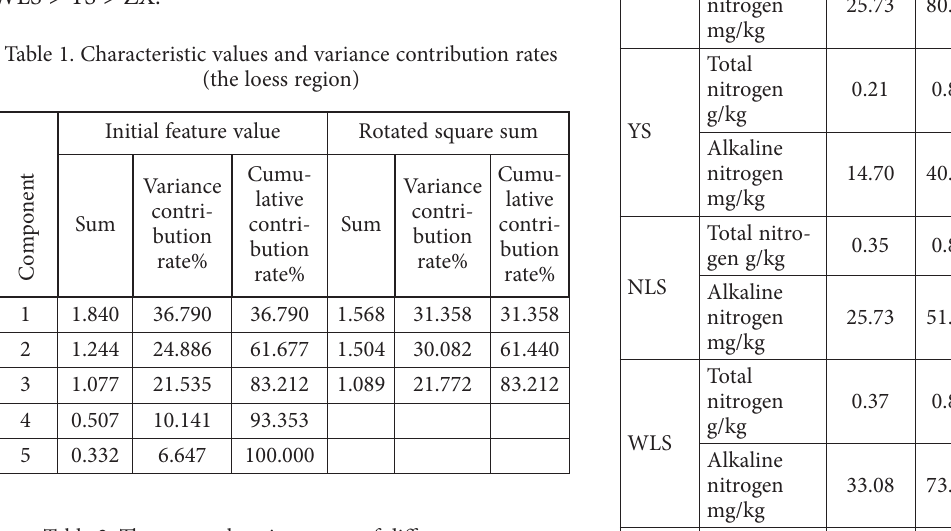
Table 2. The comprehensive scores of different zones